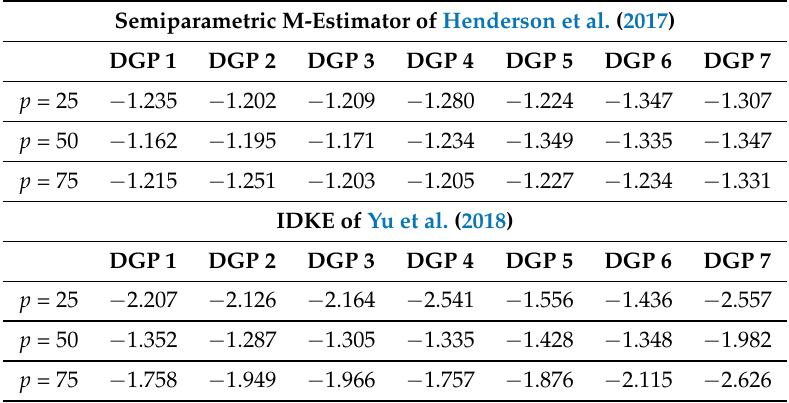
Table 8. Estimated convergence rate of the nonparametric threshold